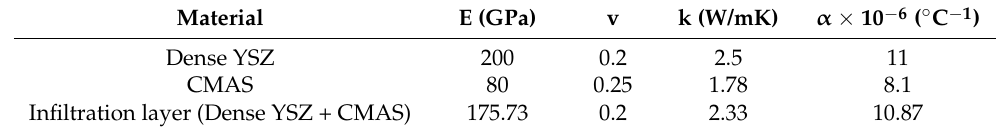
Table 2. Material properties of dense YSZ, CMAS, and infiltration layer